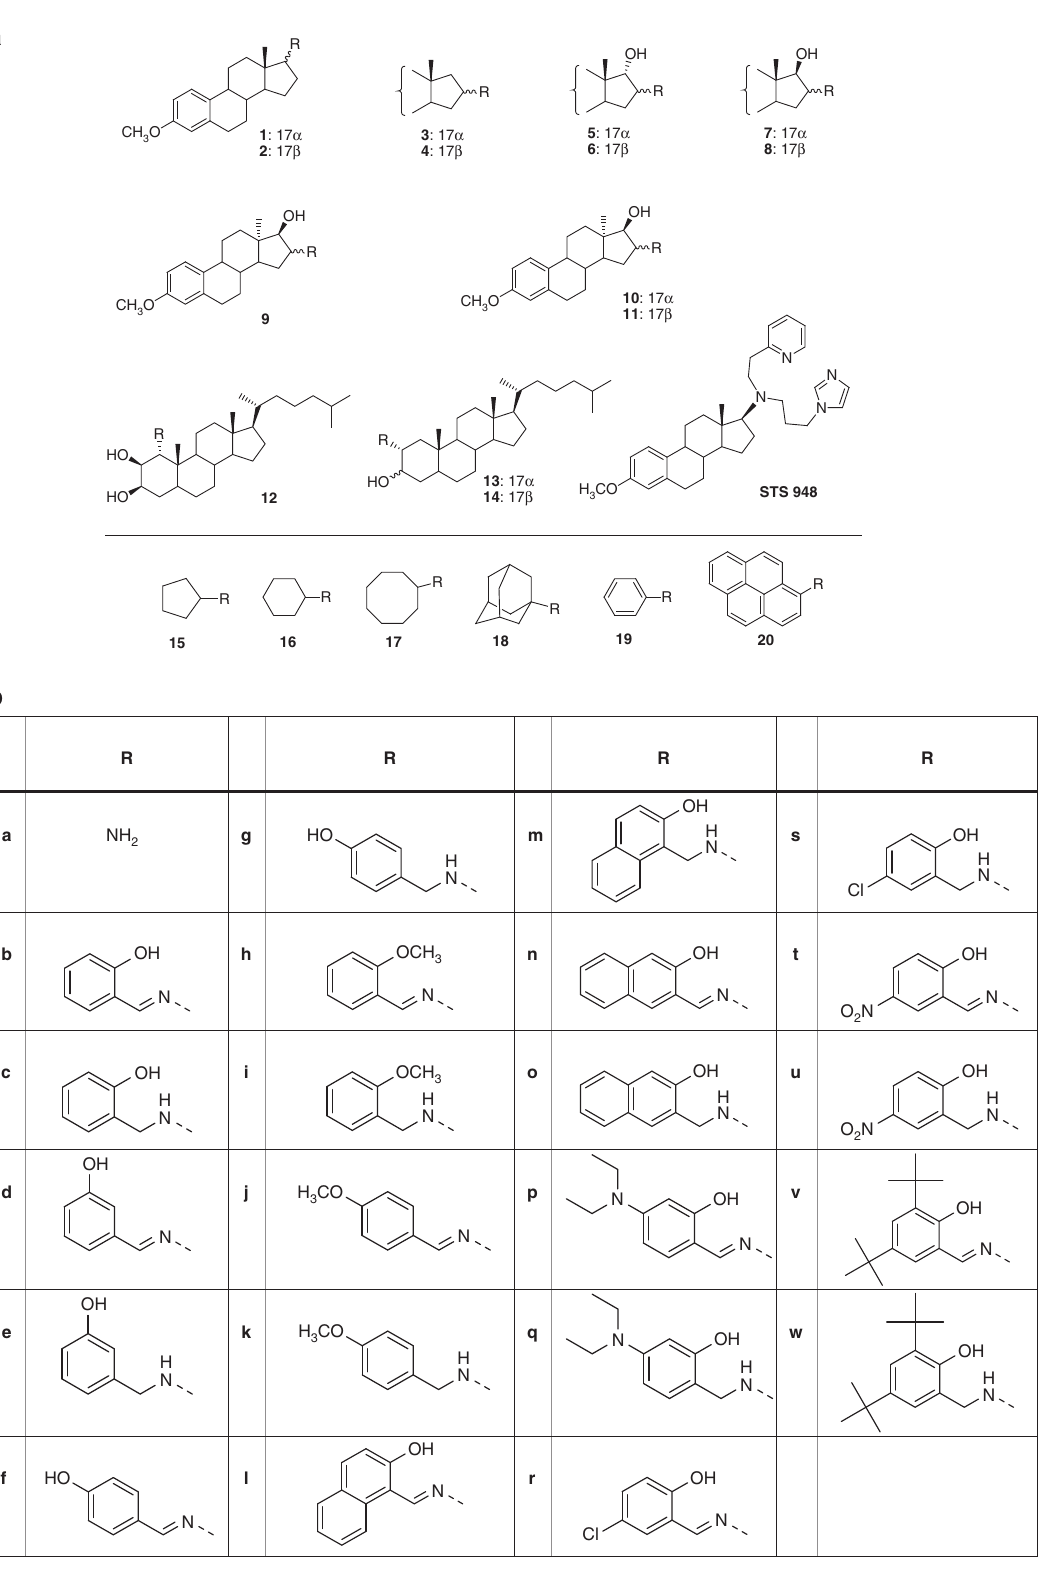
Figure 1 | Formulas of compounds investigated. ( a ) Basic structures and ( b ) corresponding substituents. Activity against P. berghei in vivo and acute toxicity . redox potential. Although these results fell short in reaching Compounds with the highest activity in the P. falciparum cell significance in the experimental setup chosen, they point towards culture were tested in an in vivo mouse model ( P. berghei ) at the a potential influence of compound 1o on the glutathione redox Swiss TPH as previously described 17–19 (Supplementary Table 2). homeostasis, which deserves to be studied in more detail. NATURE COMMUNICATIONS|8:14478|DOI: